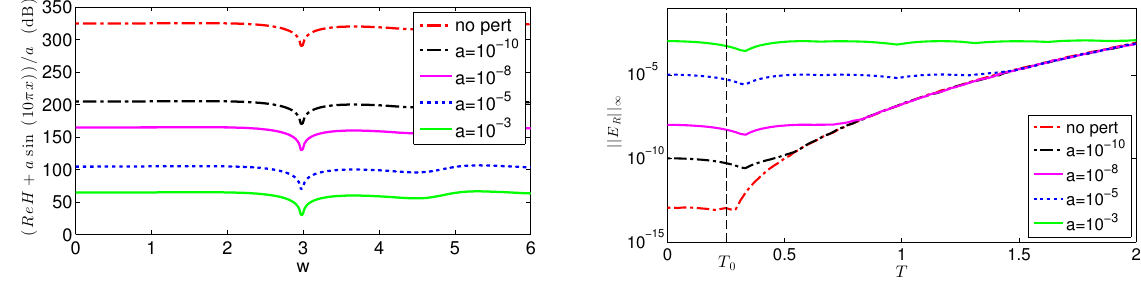
Figure 6. Left panel: profiles of perturbed Re H in the signal-to-noise ratio (SNR) format, i.e. , (Re H + a sin(10 πx )) /a , plotted in dB. Right panel: evolution of || E example with added sine perturbation a sin(10 πx ) . The vertical dashed line corresponds to = 0 . 25 . the exact delay T 0